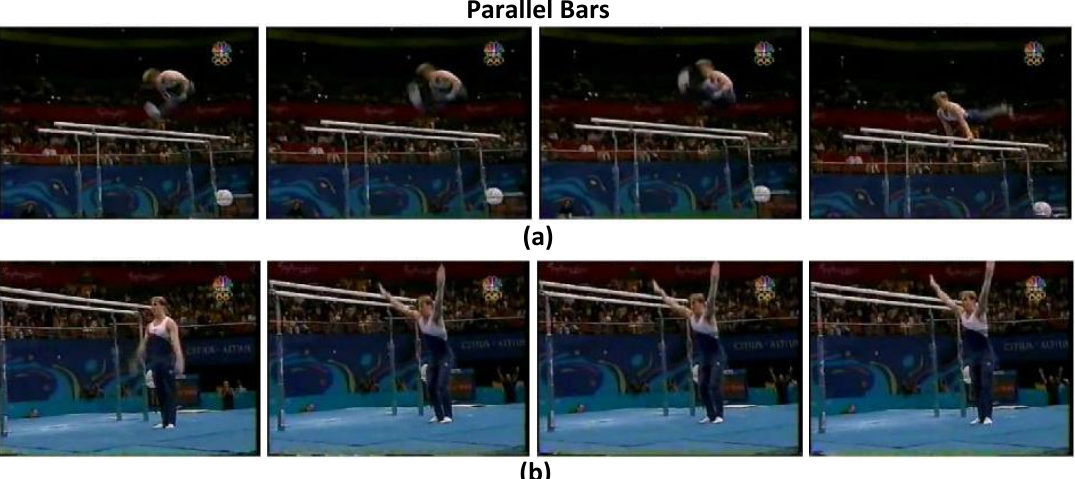
Figure 3. ( a ) The highest ranking four frames in terms of attention weights, in which the athlete is performing on the parallel bars. ( b ) The lowest ranking four frames in terms of attention weights, in which the athlete is standing on the